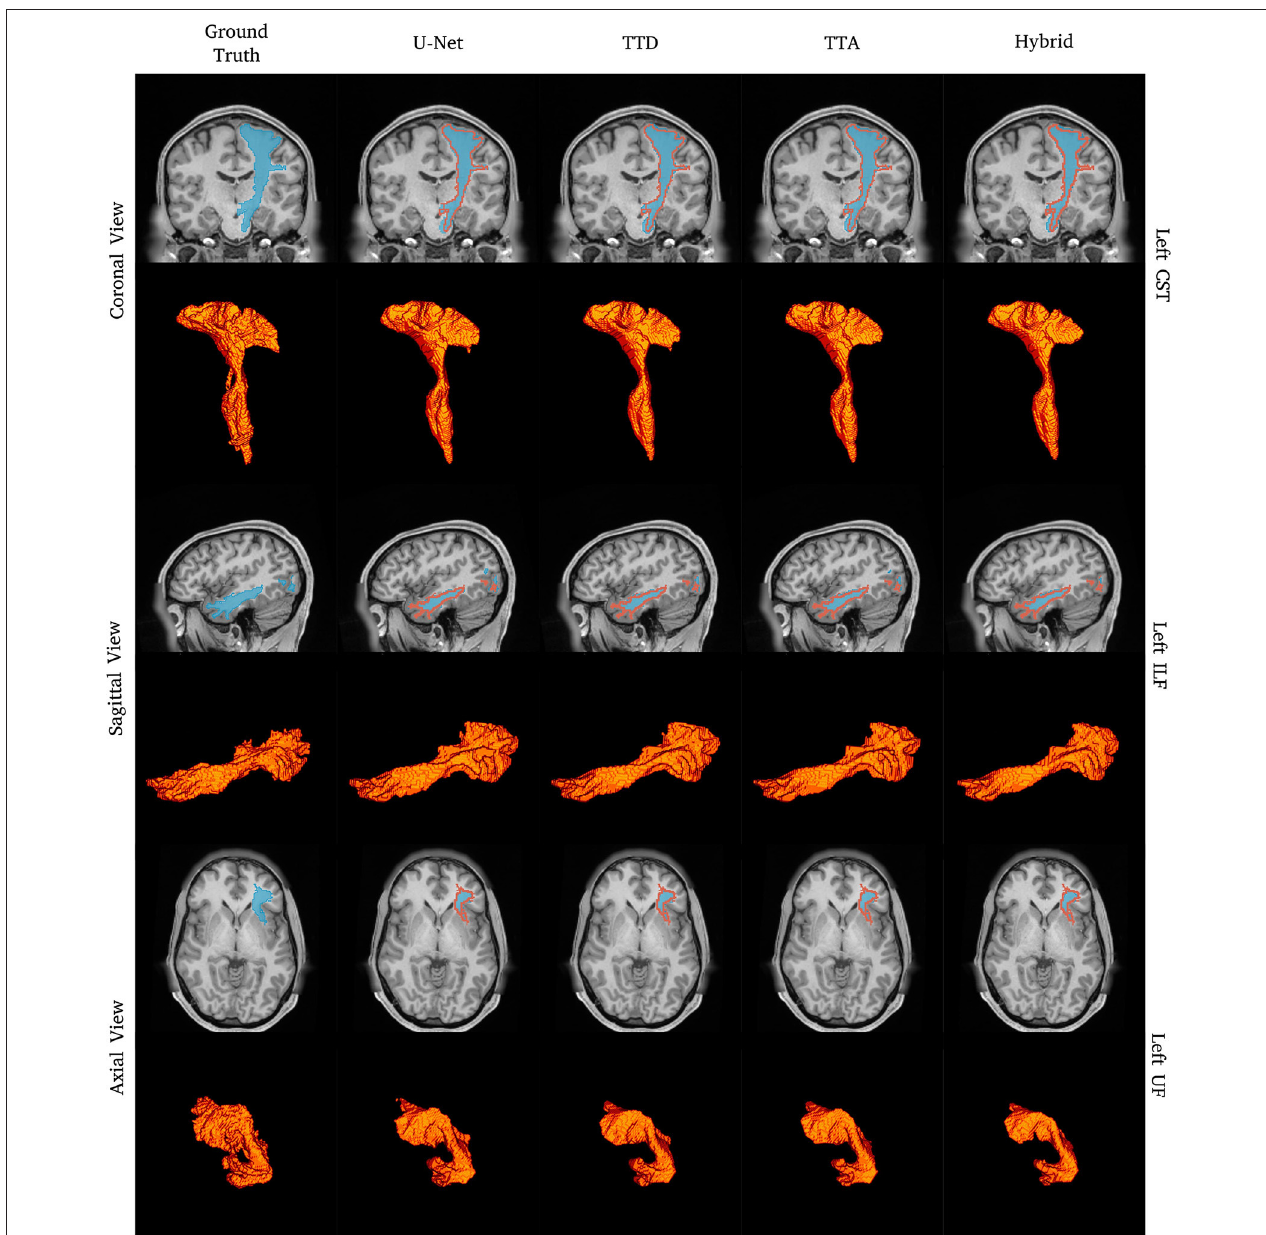
FIGURE 1 | Tract segmentation comparisons between deterministic and stochastic approaches for the left CST, ILF, and UF tracts. Red contours show ground truth